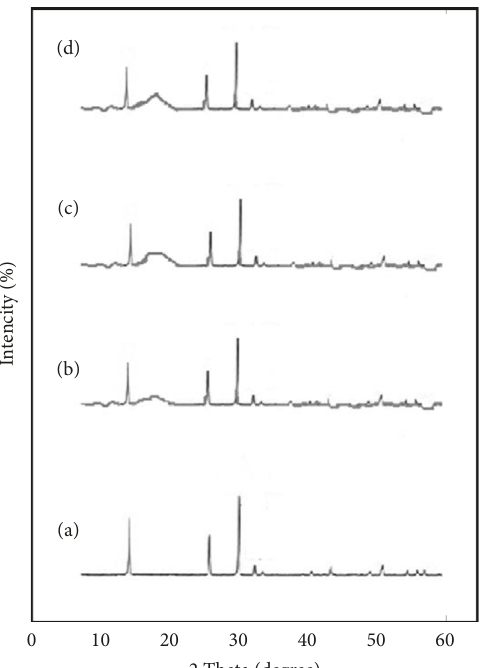
Figure 3: (a) Results for XRD for stone without silica nanoparticles, (b) stone containing 0.5% silica nanoparticles, (c) stone containing 1% silica nanoparticles, and (d) stone containing 2% silica nanoparticles.